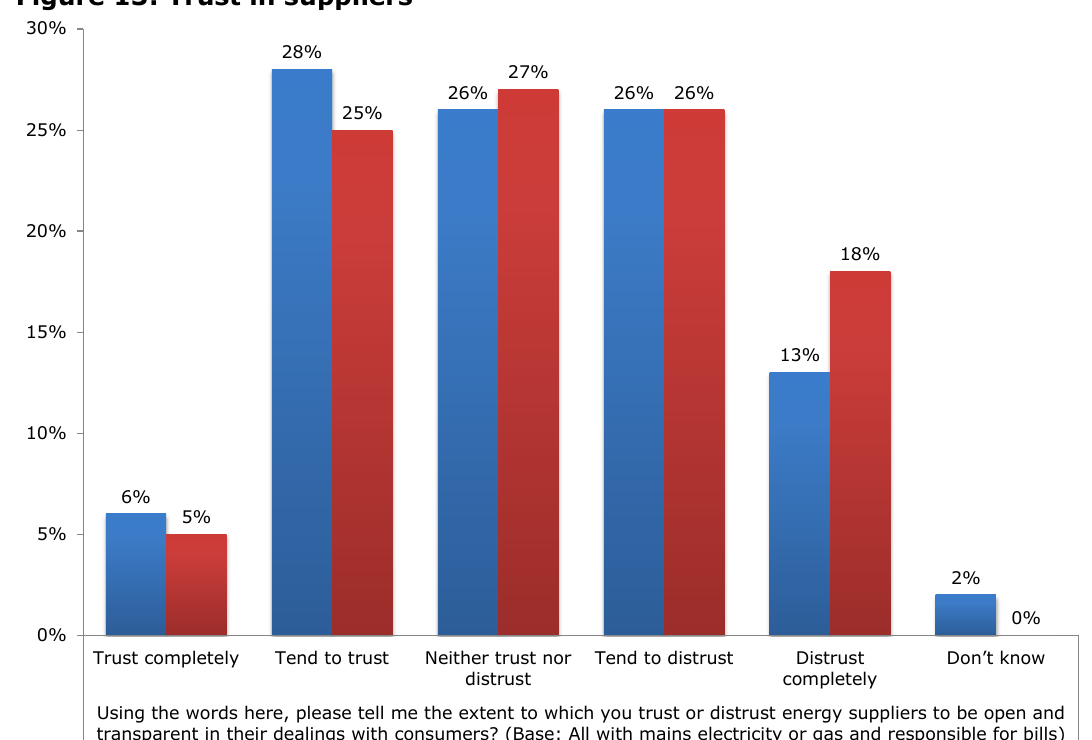
Figure 13: Trust in suppliers